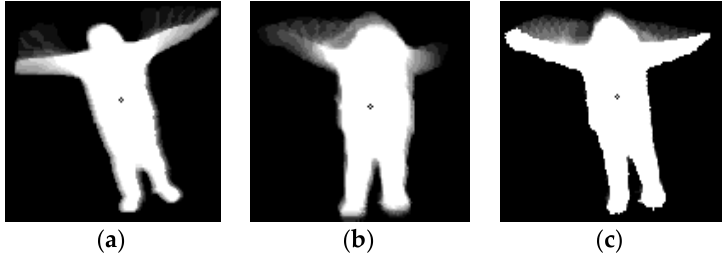
Figure 16. Examples of cases in which the GEI-based method produced an erroneous recognition result. ( a ) A small amount of waving; ( b , c ) cases in which information produced by GEI is not distinctive because the image is captured by our camera system installed at a height of 5–10 m (see Figure 12 and Table 3).